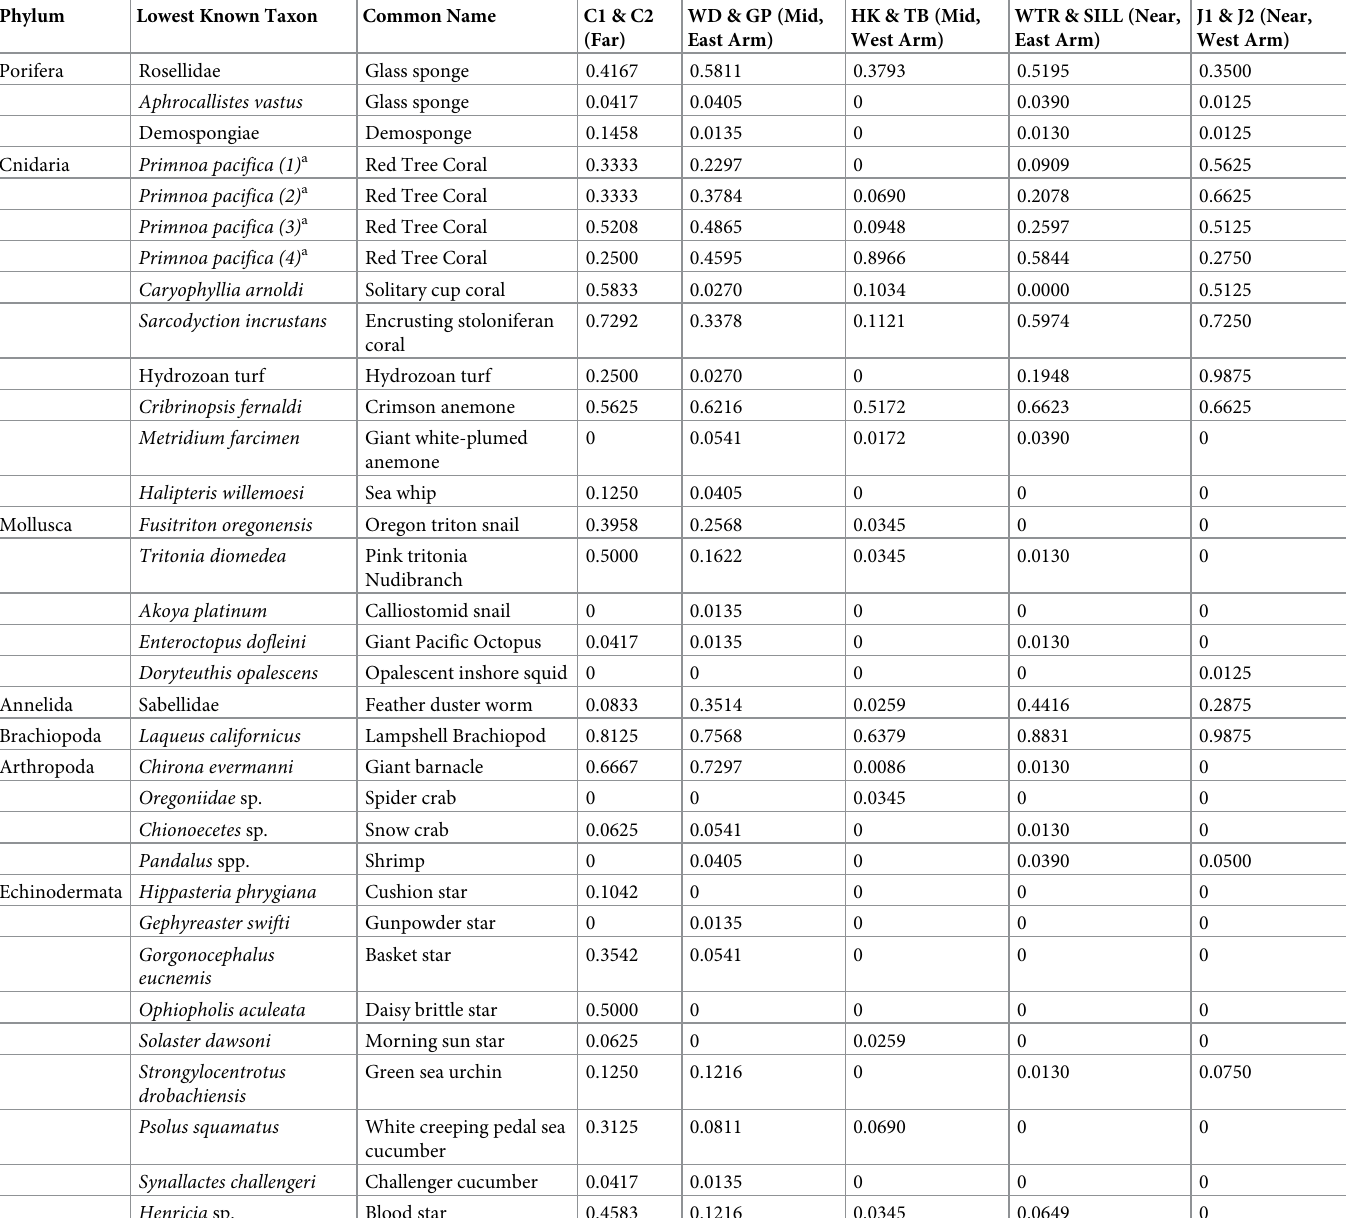
Table 2. Relative frequency of each taxon by site